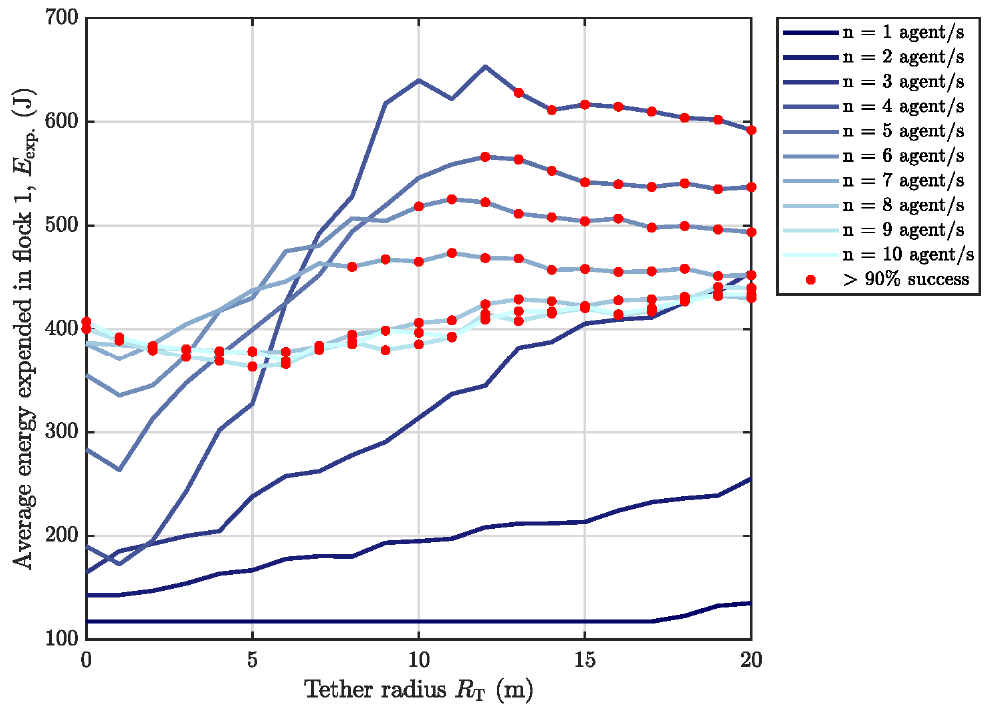
Figure 9. Single target flock scenarios–energy performance (darker lines indicate fewer agent numbers while red markers indicate data points whose average success rate is above the given threshold across the 300 independent simulation runs). Maximum agent speed 𝑣 max = 12 m/s.